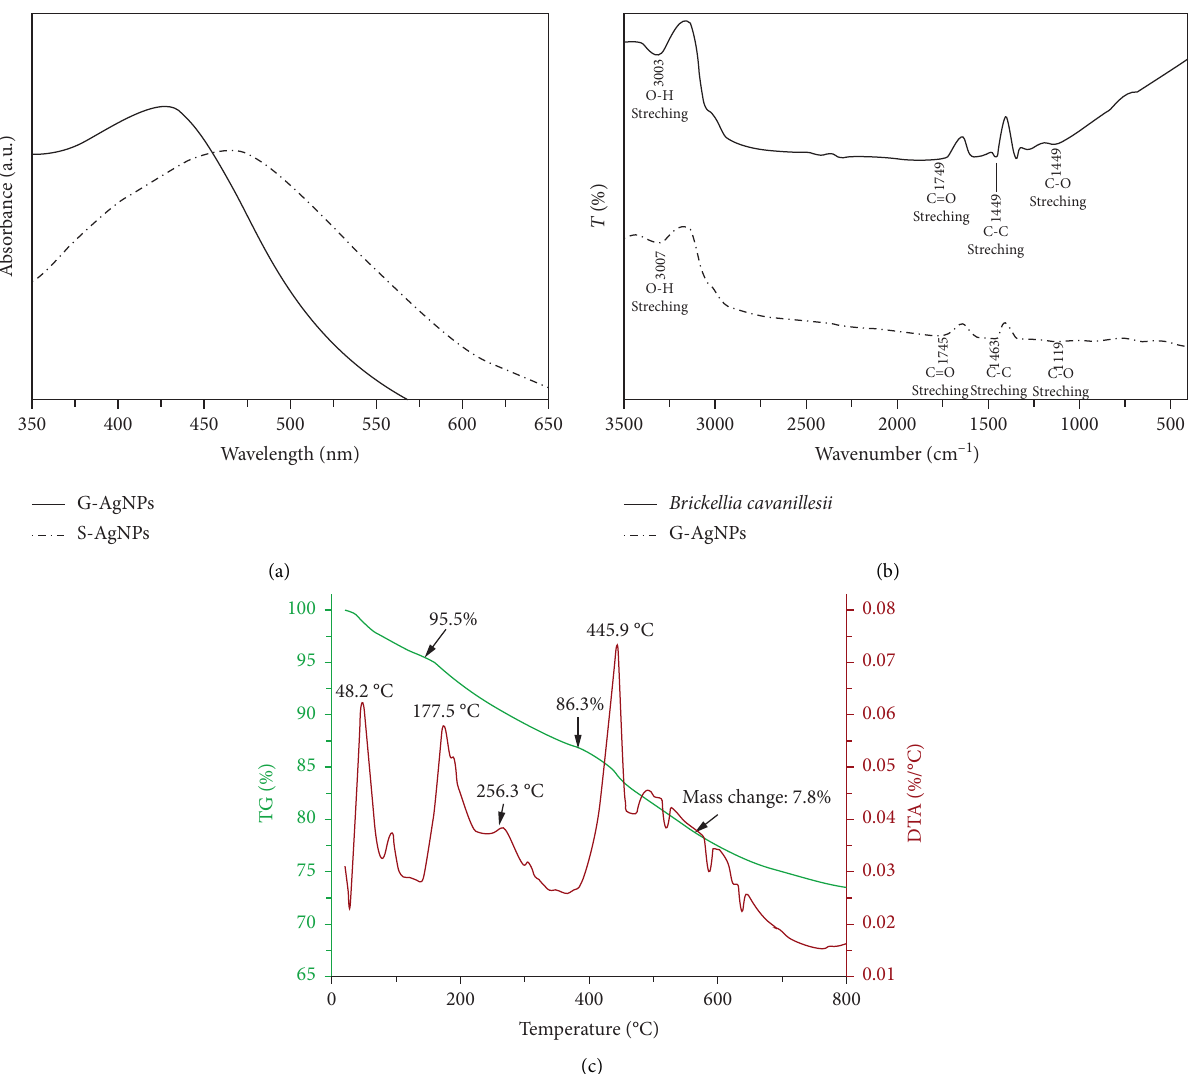
Figure 1: (a) UV-Vis absorption spectra of G-AgNPs and S-AgNPs, respectively. (b) FTIR spectrum of Brickellia cavanillesii and G-AgNPs. (c) Thermogravimetric analysis of fresh AgNPs by “green”